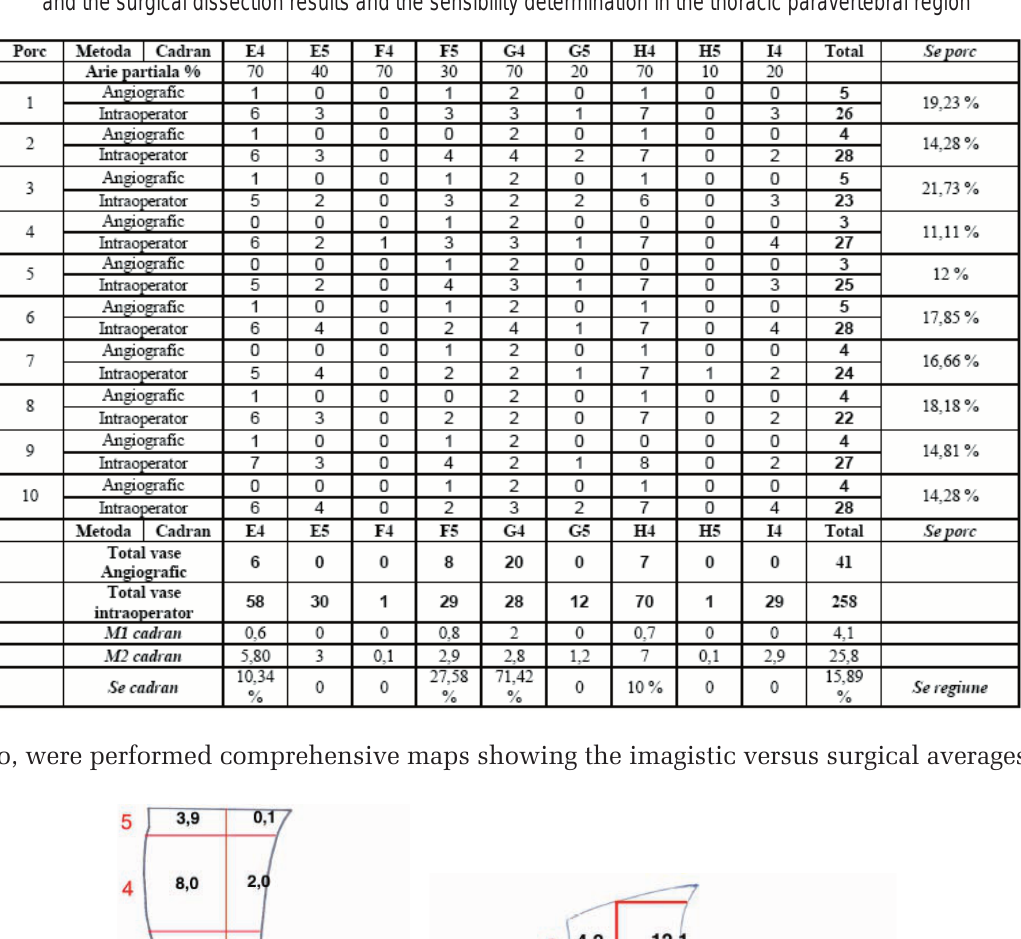
Table 2. Example of data centralization table showing the comparison between the preoperative imagistic investigations and the surgical dissection results and the sensibility determination in the thoracic paravertebral region